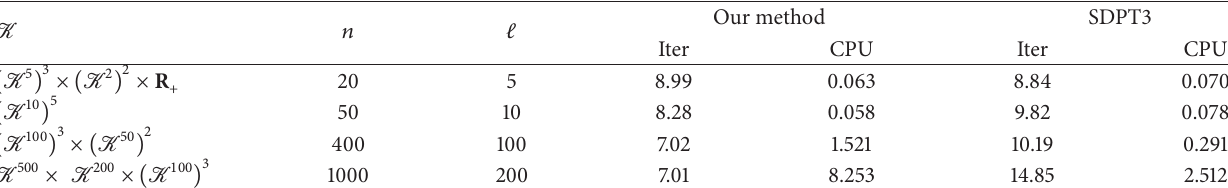
Table 1: Numerical comparison of our method with